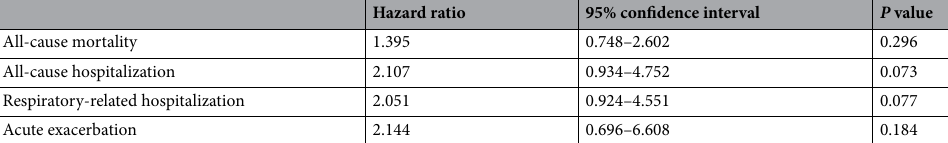
Table 3. Impact of sildenafil on the risks of clinical outcomes in patients with idiopathic pulmonary fibrosis under antifibrotic treatment * . *Assessed by multivariable Cox analyses adjusted for the presence of pulmonary hypertension and Charlson comorbidity